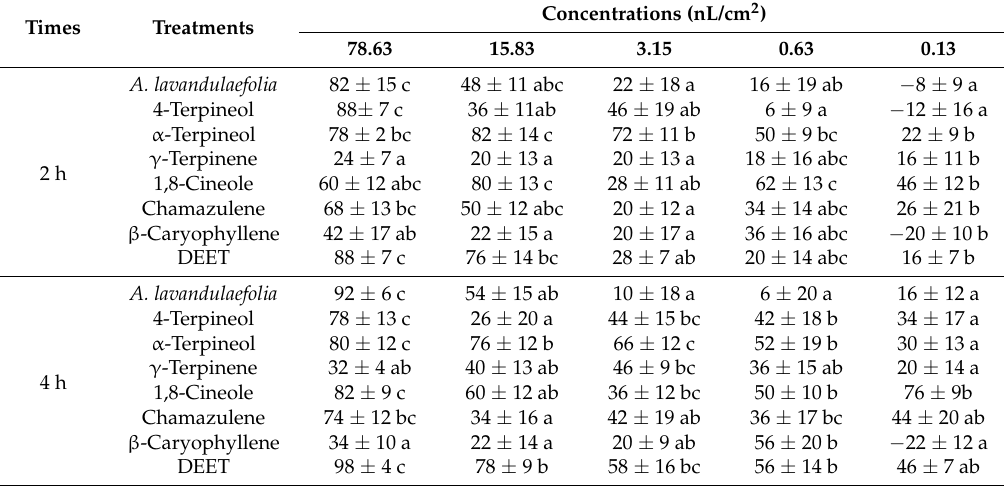
Table A1. Percentage repellency (PR) after two exposure times (2 h and 4 h) for the essential oil and its constituents against L. serricorne adults a